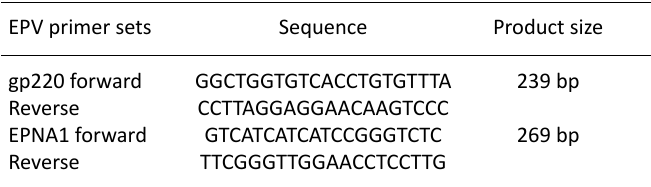
table 1. EPV primer sets and the product size 13